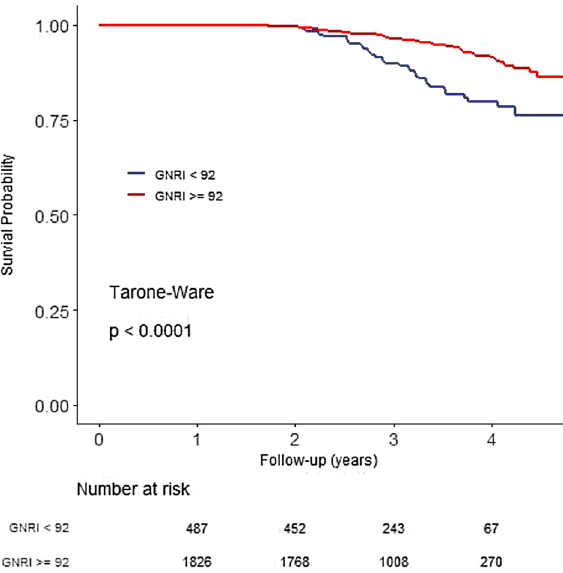
Figure 2. Kaplan–Meier survival curves for all-cause mortality: GNRI < 92 vs. GNRI ≧ 92. GNRI Geriatric Nutritional Risk